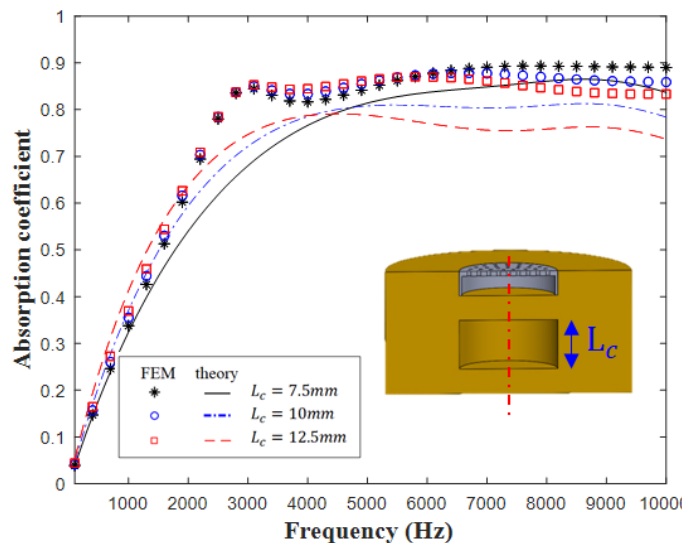
Figure 8. Influence of cavity thickness on sound absorption.